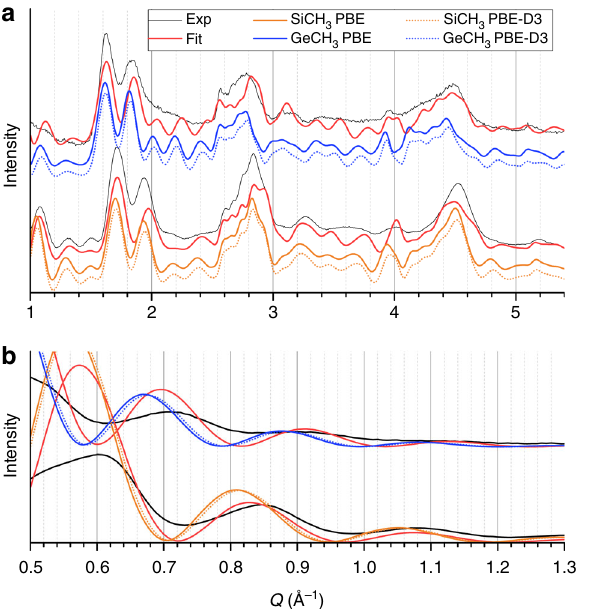
Fig. 6 Calculated WAXS diagrams for DFT-relaxed imogolite nanotubes. a Calculated WAXS diagrams for the DFT-optimized GeCH 3 and SiCH 3 INT structures at the experimentally fi tted NT-periodicity, compared to experimental (Exp) and fi tted (Fit) results. b Close-up on the small wave- vector